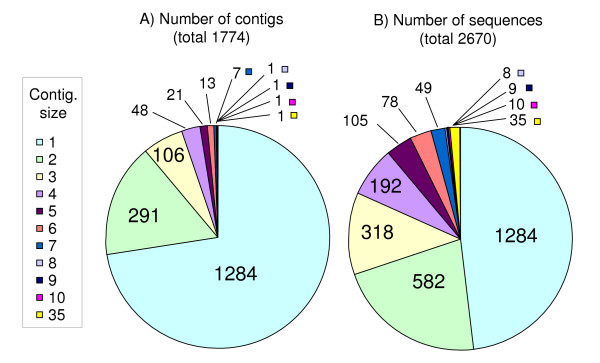
Sequence assembly. Assembly of 2670 DArT clone sequences showing (A) number of contig assemblies of different sizes and (B) number of sequences belonging to contigs of different size.